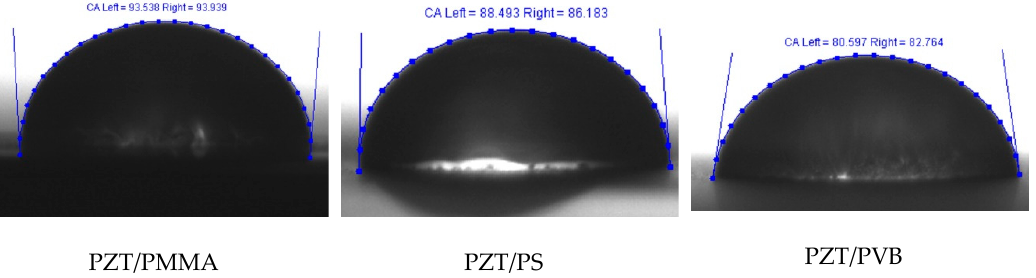
Figure 11. Polynomial fit of the droplet profile through knots starting from the left lower end to the right lower end.